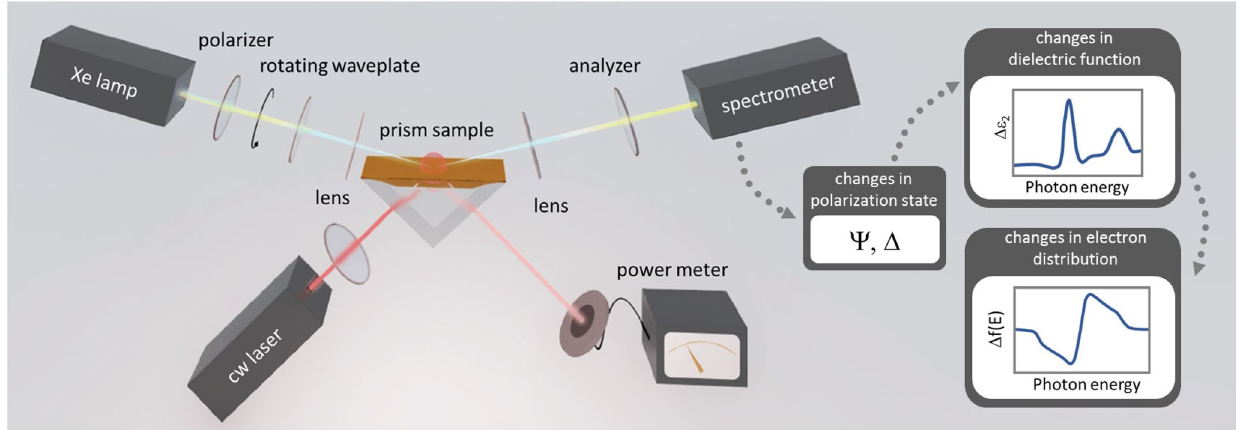
Fig. 1 | Experimental setup for ultrasensitive probing of plasmonic hot elec- trons with spectroscopic ellipsometry. SPPs are excited by a cw laser at the resonantangleofincidencefromthebackside,whileellipsometricdataisrecorded on the gold-air interface with white-light probing from the top. These